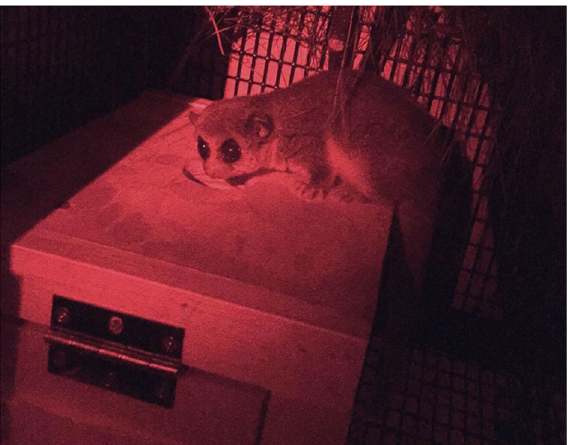
Figure 1. Fat-tailed dwarf lemur “To” about to enter the wooden box used as hibernaculum during the study.